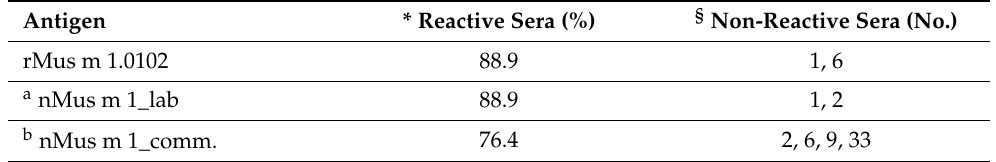
Table 2. Positive sera reactivity to recombinant and urinary Mus m 1 samples, assessed by ELISA. Antigen * Reactive Sera (%) § Non-Reactive Sera (No.) rMus m 1.0102